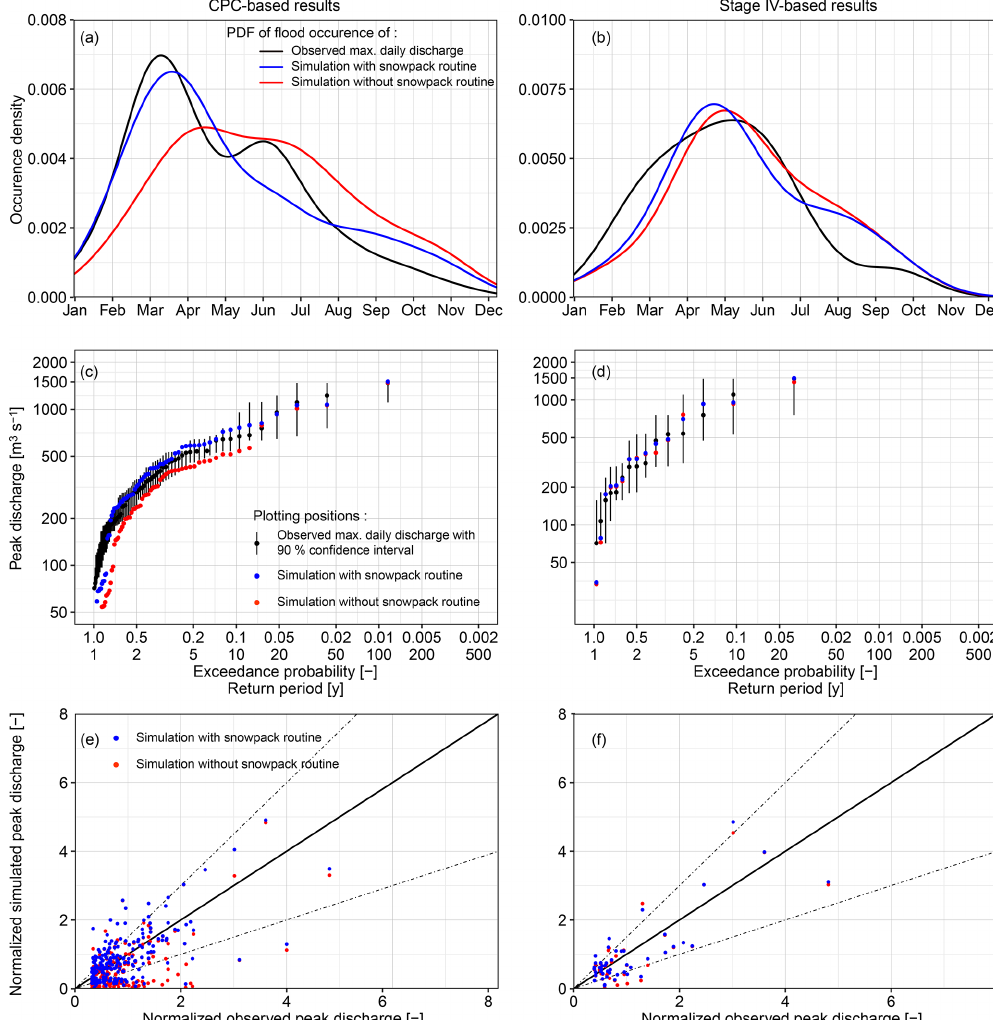
Figure 4. HBV model validation for flood seasonality (a, b) , frequency of annual maximum daily discharge (c, d) , and normalized peak flow (e, f) for CPC and Stage IV-based continuous simulations. Model validation is performed for HBV simulations with and without using CPC for 1948–2016 (a, c, e) and Stage IV for 2002–2016 (b, d, f) . The 90% confidence intervals for the empirical distributions of observed maximum daily discharges (c, d) are derived using nonparametric bootstrapping. Flood peak discharge in (e) and (f) is defined as a data point with an USGS-observed value that is at least 3 times the average observations. Peak discharges are normalized by the median of annual daily discharge maxima (i.e., the 2-year flood). Straight solid black lines indicate 1 : 1 correspondence, while dashed lines denote an envelope within which the modeled values are within 50% of those